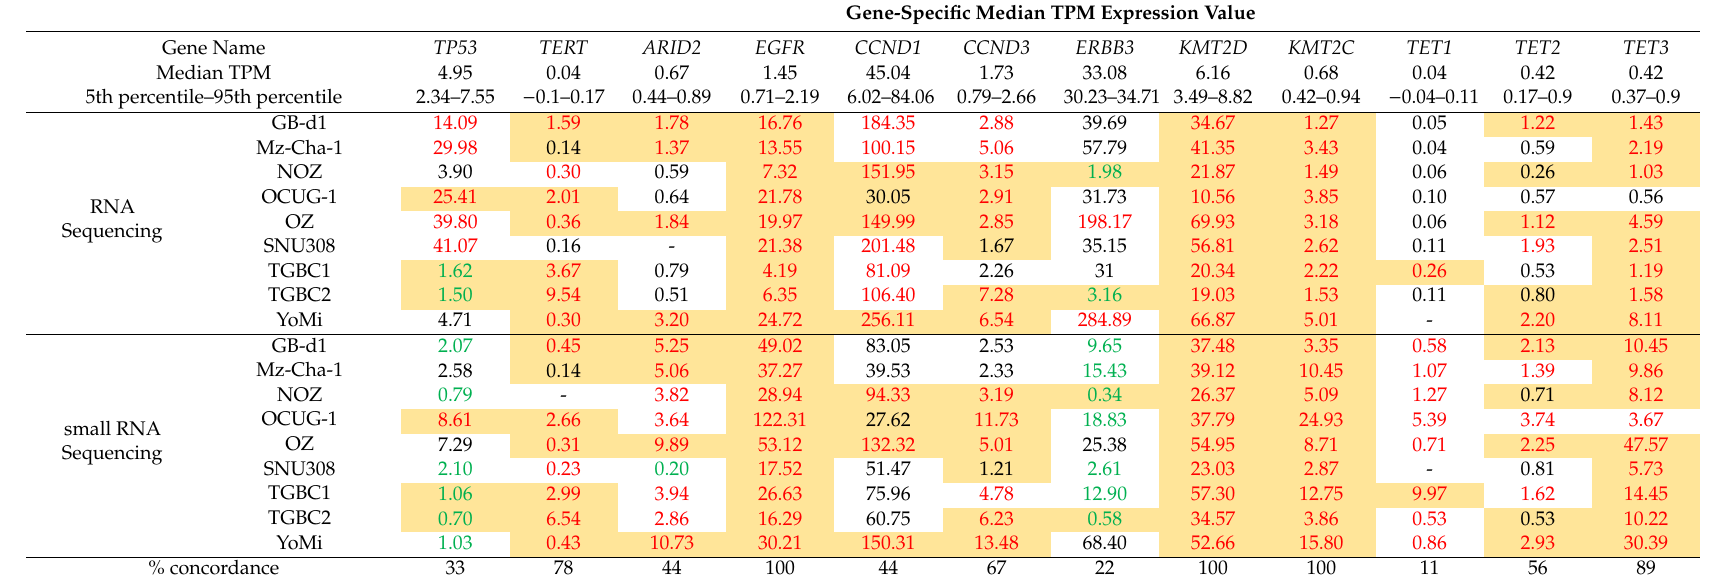
Table 2. Expression of particular genes in the investigated gallbladder cancer cell lines using RNA sequencing and small RNA sequencing. TPM—transcripts per